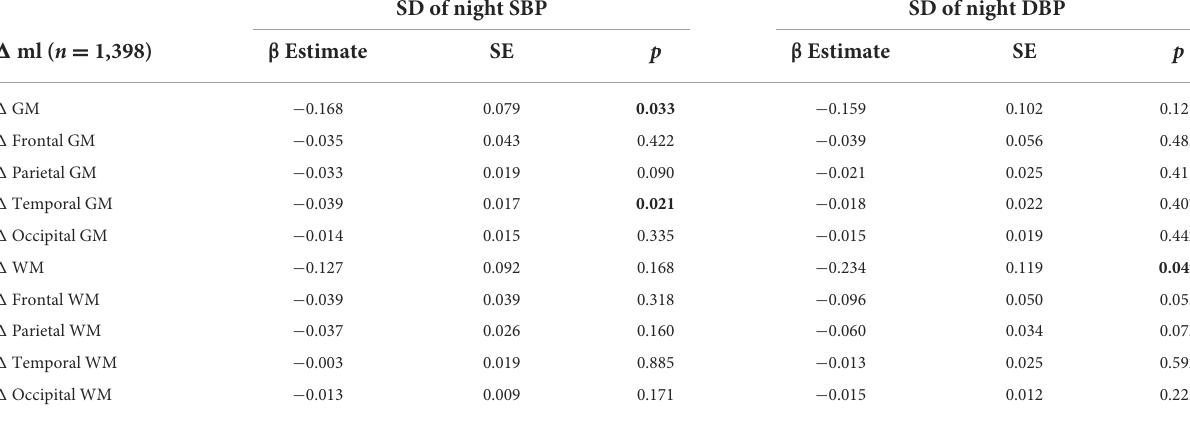
TABLE 3 Linear regression analyses between night BPV and regional brain volume